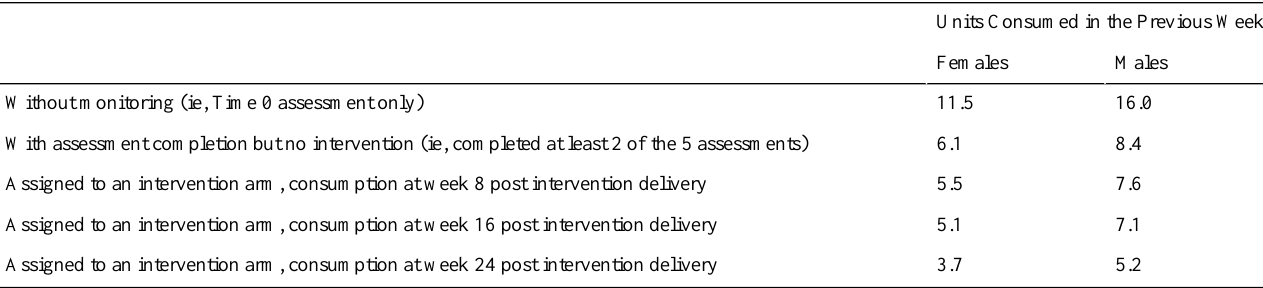
Table 3. Prediction of units consumed over the last week at each time point (longitudinal regression model)